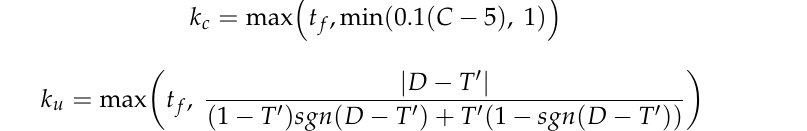
Figure 8. Detailed example of process shown in Figure 7b noise extraction via morphological operations: ( a ) Raw binary image M0 produced by thresholding reprojected density map D with Niblack threshold T; ( b , c ) Applying morphological opening process followed by a thinning operation to M0 to produce M1 ; ( d ) The difference between M0 and M1 contains low density noise and excess thickness of segments, which will be used in T ′ and Equation (6) to weigh the loss magni ‐ tude.